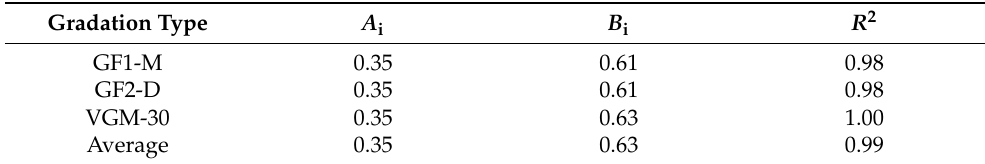
Table 9. Fitting regression coefficients of R iT / R i ∞ ~ T